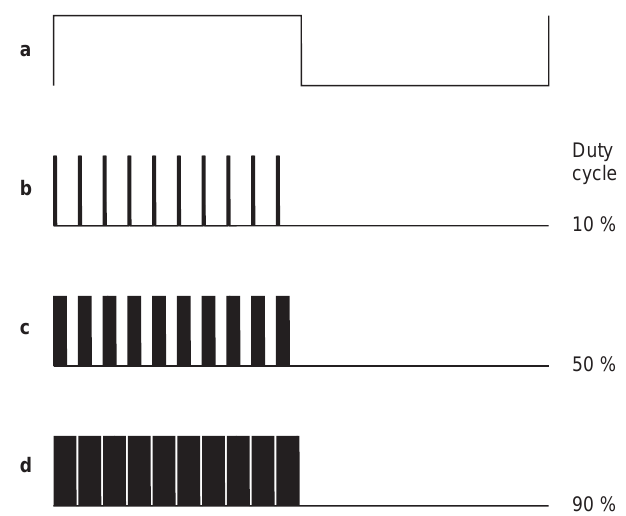
Fig. 3. HF heater transmitter keying waveform. a desired ELF current in ionosphere, b – d e(cid:128)ective HF output from heater transmitter with pulsed amplitude modulation of 10, 50 and 90% duty cycle